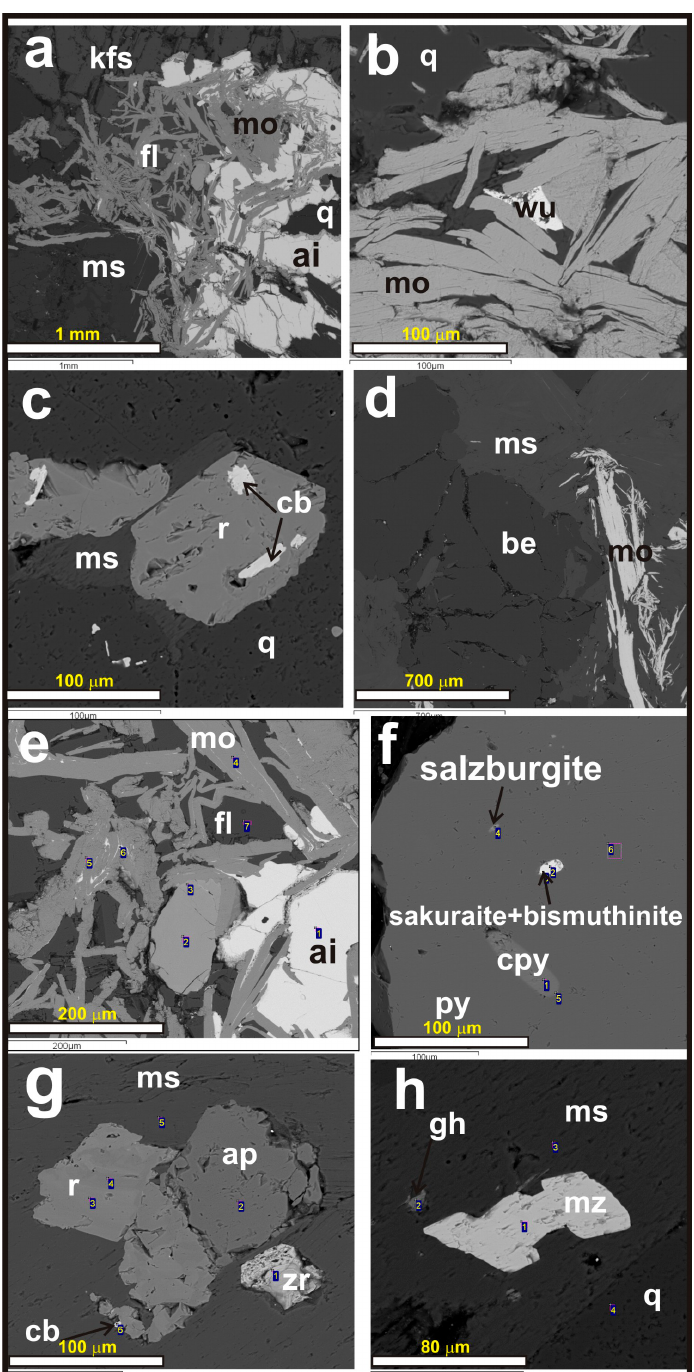
Figure 6. Ore minerals in quartz-molybdenite veinlets of the Pervomaiskoe deposit (photos in back-scattered electrons). ( a ) molybdenite aggregate in close intergrowth with aikinite; ( b ) wulfenite grain in the laminated aggregate of molybdenite; ( c ) inclusion of columbite in rutile; ( d ) beryl grains in contact with muscovite and molybdenite; ( e ) molybdenite with fluorite and aikinite; ( f ) microinclusions of rare sulfosalts and chalcopyrite in pyrite; ( g ) grains of rutile, apatite, zircon, and microinclusion of cubanite on contact with muscovite; ( h ) monazite and goethite grains; Abbreviations: mo—molybdenite; q—quartz; kfs—potassium feldspar; ms—muscovite; fl—fluorite; ai—aikinite; be—beryl;